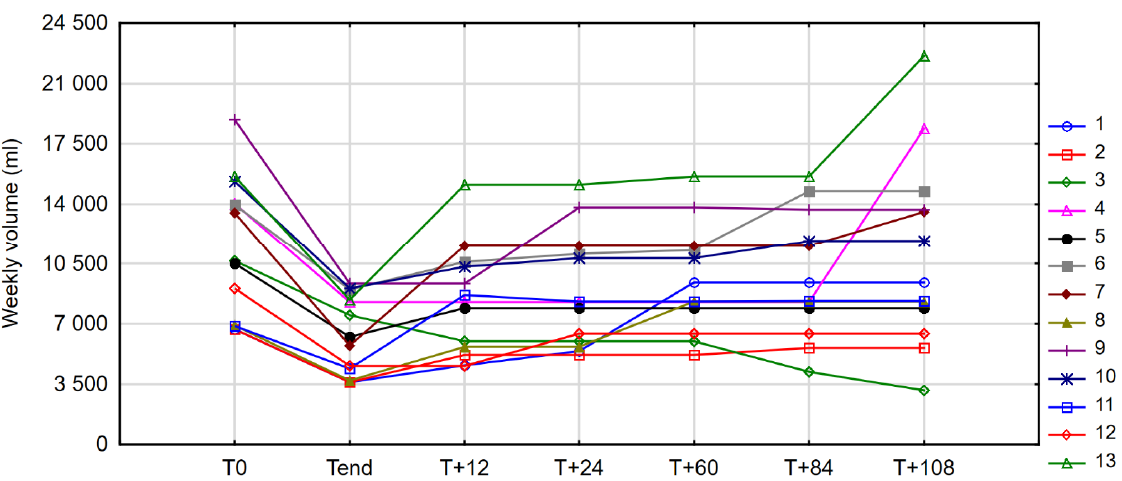
Figure 5. Changes in weekly parenteral nutrition (PN) volume in individual patients between ob- servation time points (case profiles). observation time points (case